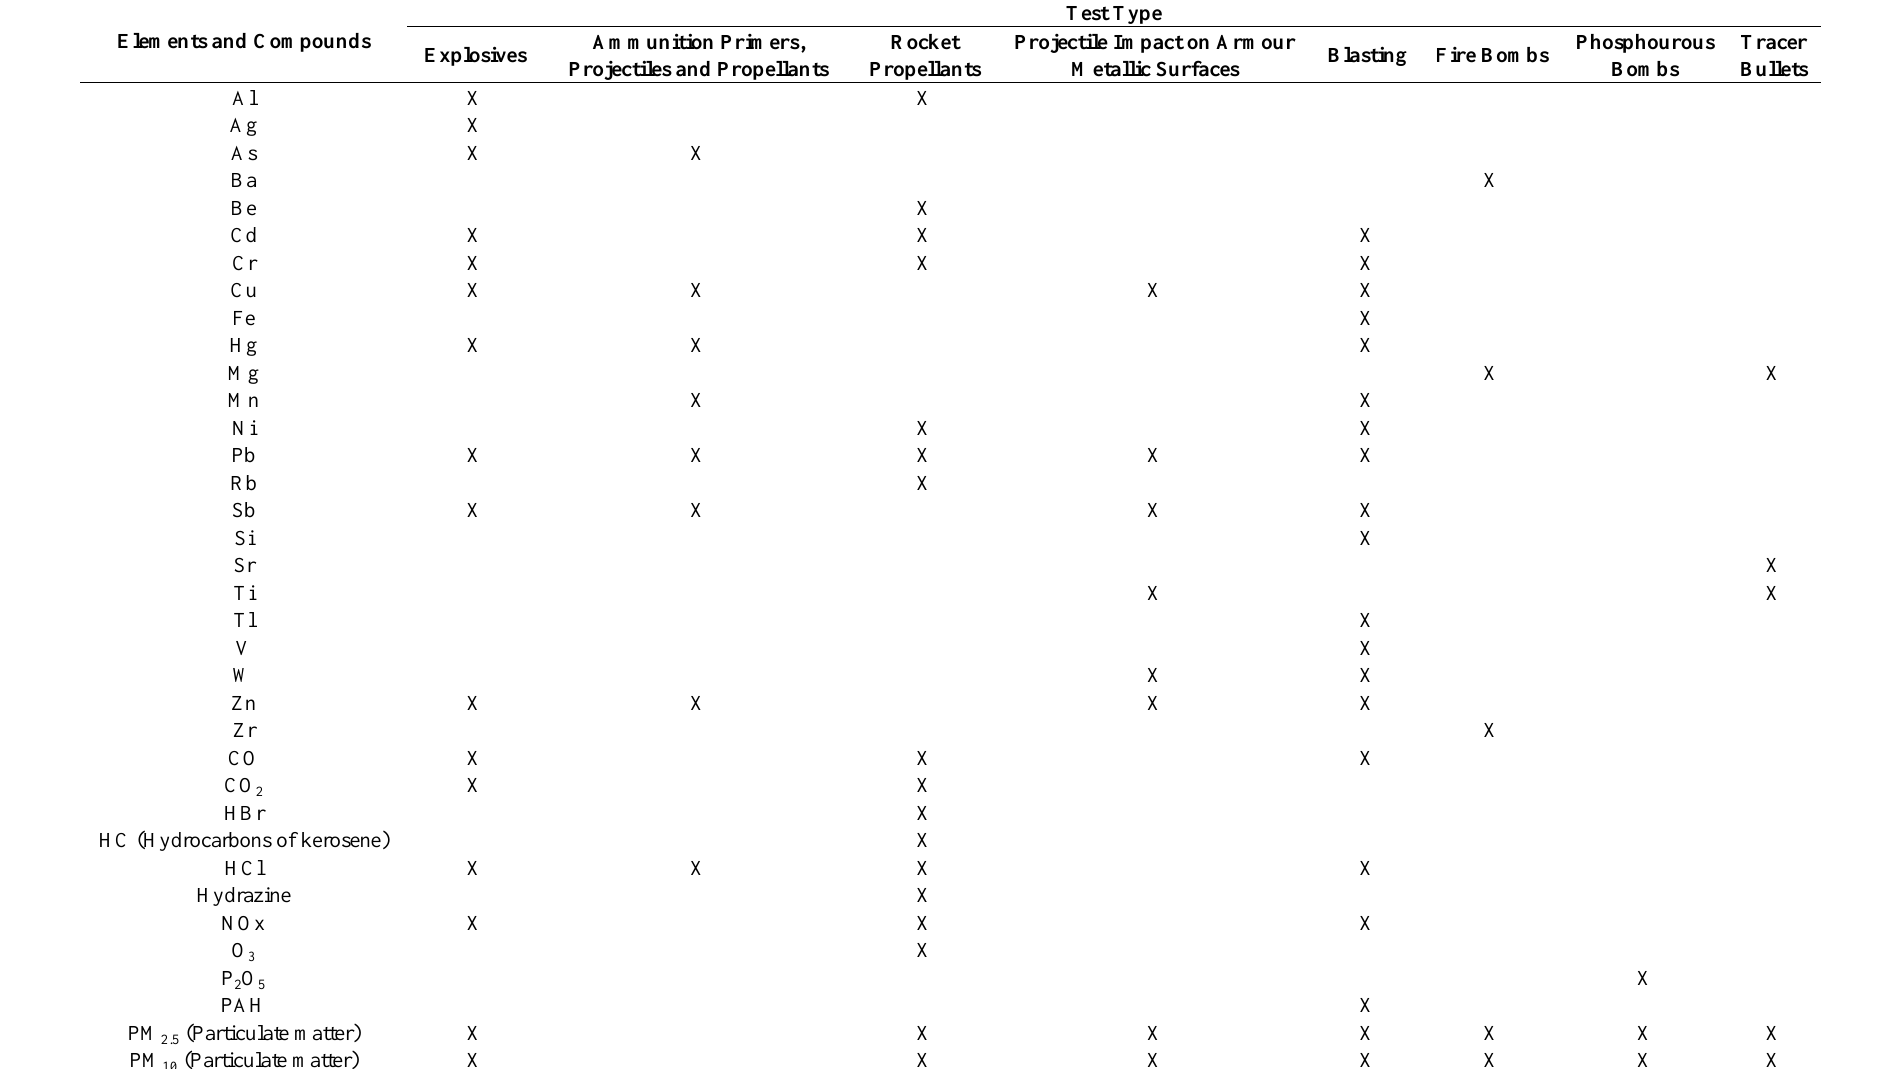
Table 1. Element and compound emissions by military exercises and testing